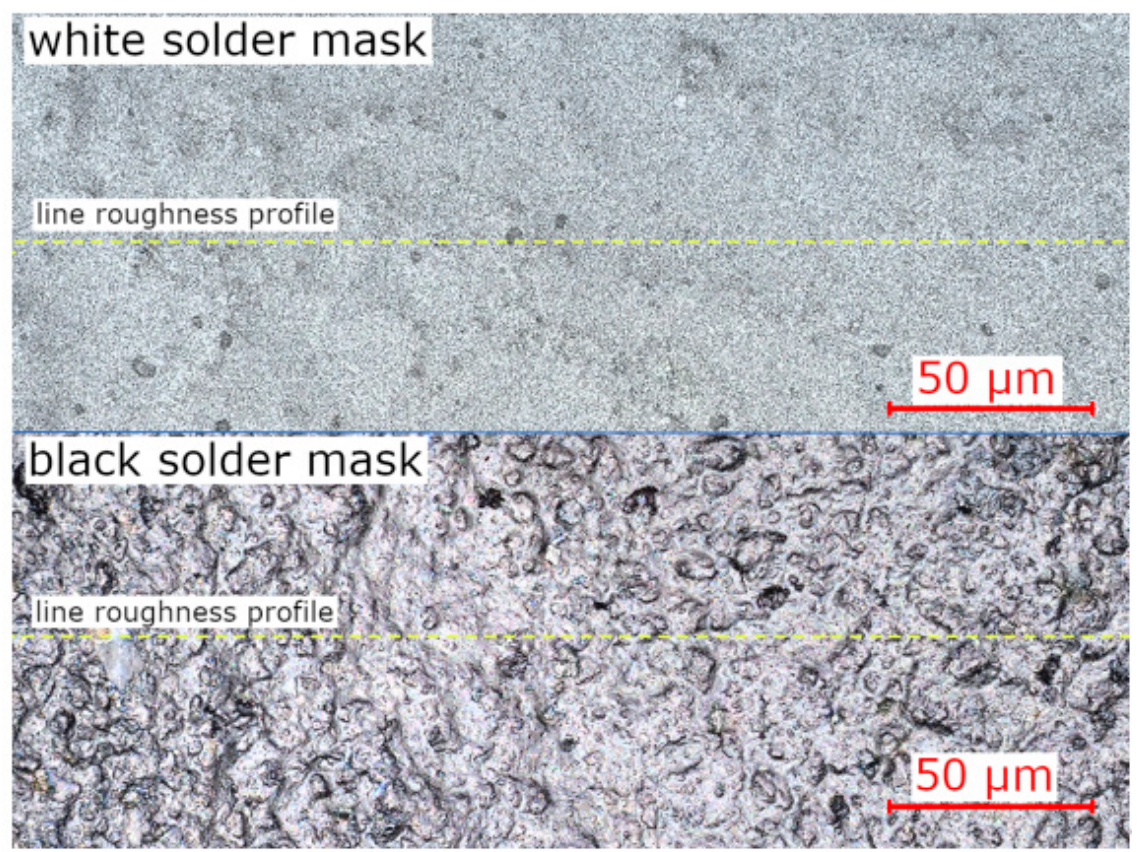
Figure 6. Solder masks—images from the laser confocal microscope. White ‐ low roughness ( top ) and black ‐ high roughness ( bottom ).